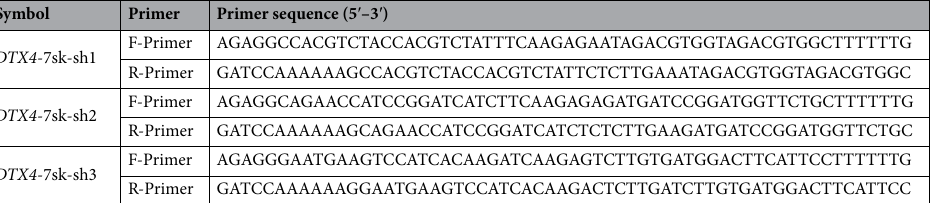
Table 3. Primer sequences.